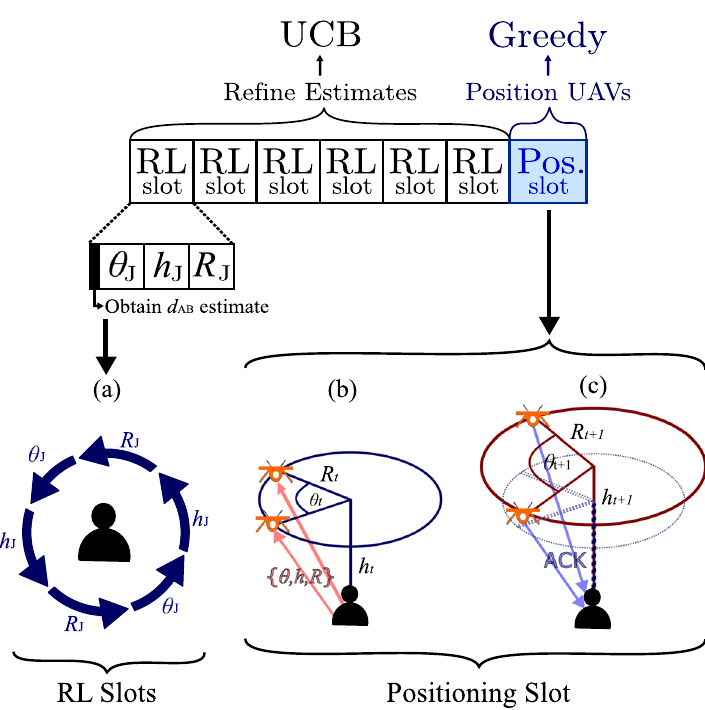
Fig. 4 PLB‑based WSC improvement algorithm. a Iterative RL processes on the three positional variables θ J , z J and R J in A, over the RLSs of the PLB, b signalling from A to the UAVs to adopt new positions, and c UAVs sending ACK signalling back to A after adopting their new